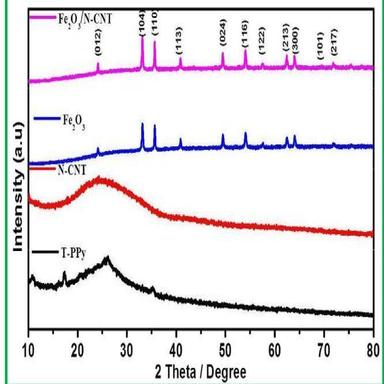
XRD pattern of T-PPy, N-CNT, bare Fe2O3 and Fe2O3/N-CNT.